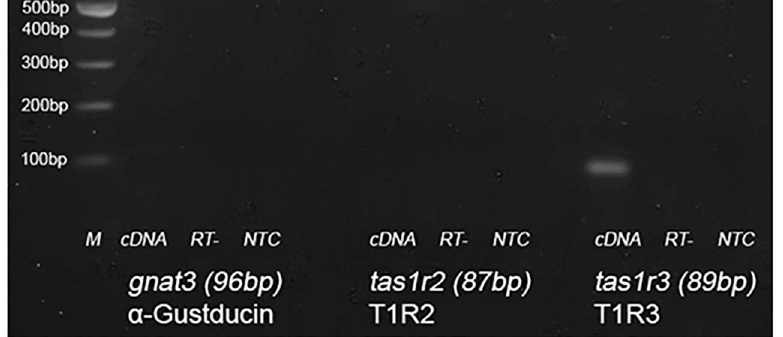
Fig 5. Identification of sweet taste receptor transcripts expressedin Caco-2/TC7 cells. RNA was isolatedfrom Caco-2/TC7 cells grown for 21 days and convertedto cDNA. The presenceof α -Gustducin (gnat3), T1R2 (tas1r2) and T1R3 (tas1r3) transcripts was undertaken by PCR. (M) represents the molecular weight marker ladder. For each gene, (cDNA) represents a PCR amplification using Caco-2/TC7 cDNA as a template, (RT-) represent a PCR using template obtainedfrom a reverse transcriptase reaction without enzyme. (NTC) represents a PCR using no